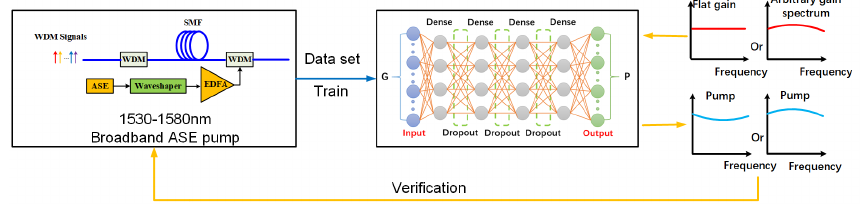
Figure 1. The procedure of inverse design.